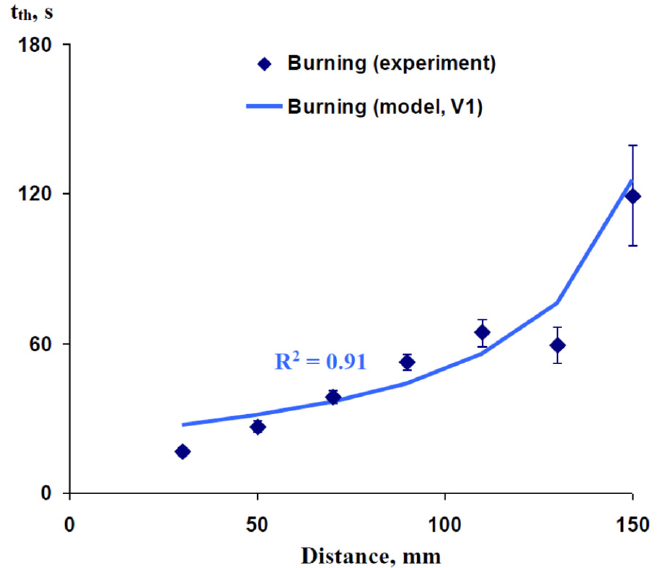
Figure 2. Experimental and simulated dependence of the time of initiation of variation potential ( t th ) on the distance from the burned zone in wheat seedlings. We used experimental data from our previous work [62]. The length of the xylem vessel (L) is assumed as 200 mm (on the basis of [62]). The duration of hydraulic changes in the damaged zone (t R ) is assumed as 200 s. The ratio of the P’ integral, which is necessary for variation potential induction, to the total P 0 ’ integral in the zone of damage (N) is assumed as 0.13. Only Variant 1 (V1) of the model was used in this analysis (see Figure 1b). It is assumed that V1 (instant initial increase in pressure and subsequent linear decrease) is in accordance with the action of short-term burning. R 2 is the determination coefficient. Figure 3 shows the experimental (pea seedlings, data from work [63]) and simulated dependence of the propagation rate of VP (V VP ) on the distance from the damaged zone. Two types of short-term damages were used in this analysis: burning of leaf and crushing of leaf. The propagation rate of burning-induced VP was about 8.4 mm s − 1 at a 38 mm distance from the zone of damage; V VP strongly decreased with an increase in the distance from the burned zone and was about 3.9 mm s − 1 at a 90 mm distance. The model well simulated the experimental dependence (R 2 was 0.86) at t R = 50 s and N = 0.58. The propagation rate of crush-induced VP had a similar dependence on the distance from the damaged zone; however, V VP was significantly lower (V VP = 1.3 mm s − 1 at 38 mm and V VP = 0.6 mm s − 1 at 90 mm). The developed model well simulated this dependence at the same N (N = 0.58) and t R equaling 325 s. It should be noted that the integral of total pressure changes (Q S ) was also constant at constant N because N ≈ (Q S ) − 1 = (0.5P m ’t R ) − 1 , where P m ’ is the maximal pressure in the damaged zone (see Figure 1 and Section 2); i.e., the increase in t R corresponded to a proportional decrease in P m ’. In contrast, the dependence of the propagation rate of crush-induced VP on the distance from the damaged zone could not be simulated only by changes in N (without changes in t R ); i.e., an increase in the duration of pressure changes was necessary for an adequate description of experimental results at crush (data not